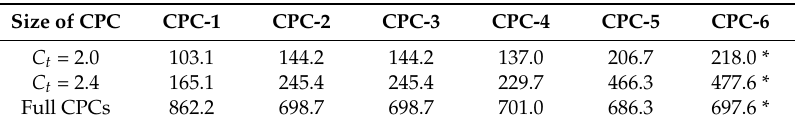
Table 3. Depth of CPCs with θ a = 20 ◦